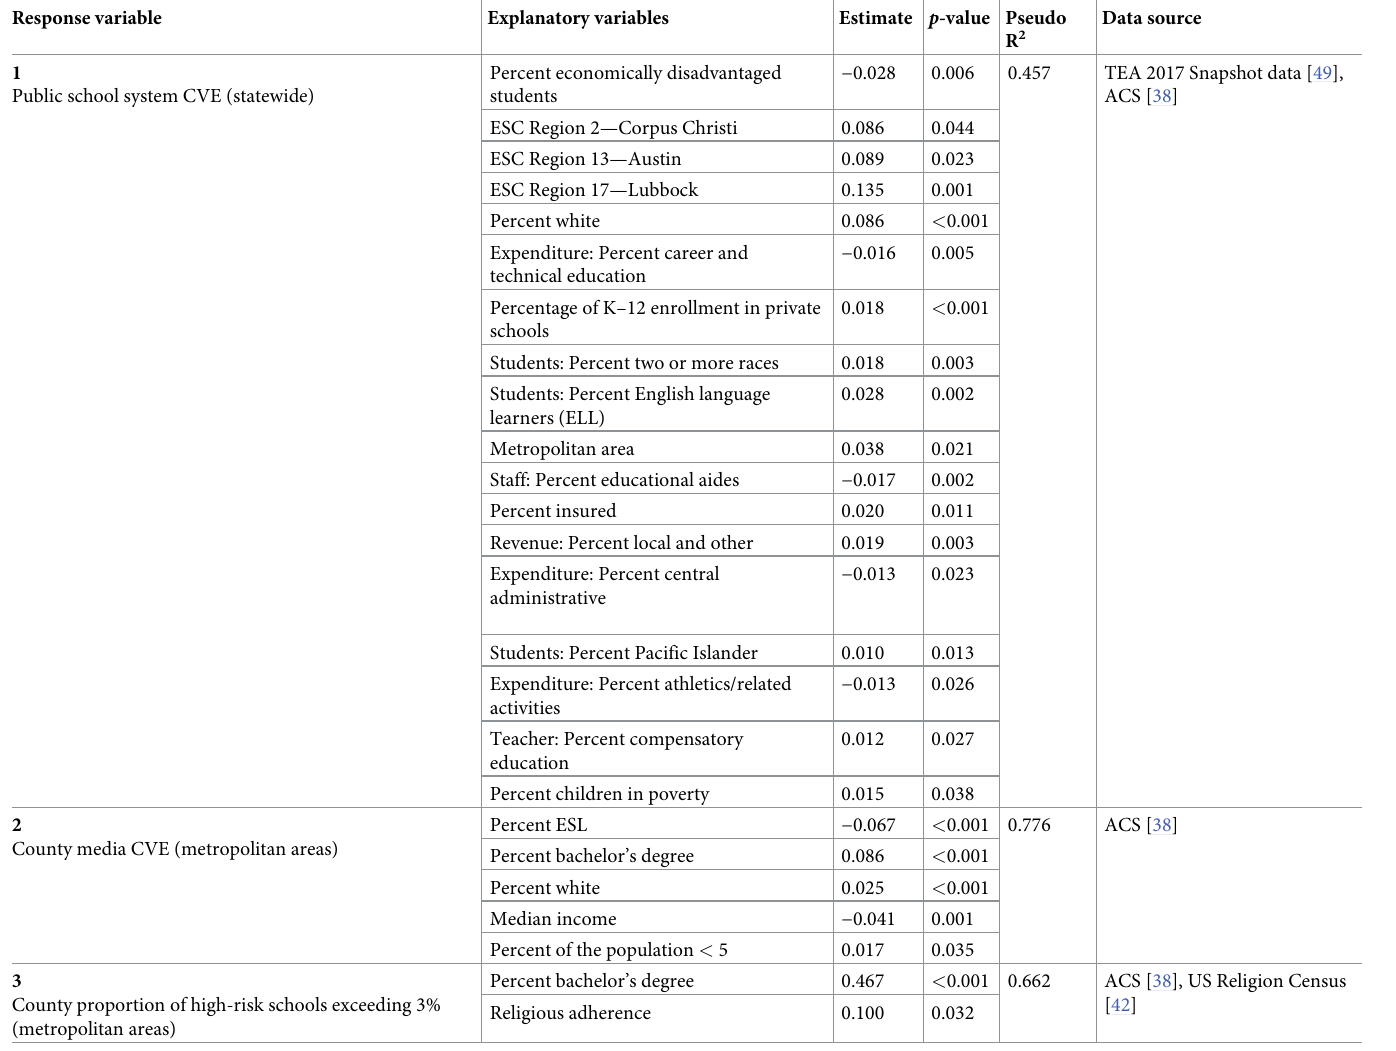
Table 1. Explanatory variables for CVE risk models. School-system-level variables come from the TEA Snapshot district profiles that provide characteristics about Texas public education and from the US Census Bureau ACS. County-level variables come from the ACS and the US Religion Census. Variable definitions are provided in S1 Table. Educational Service Centers (ESC) support local districts in meeting TEA objectives and serve as a geographic proxy. Response